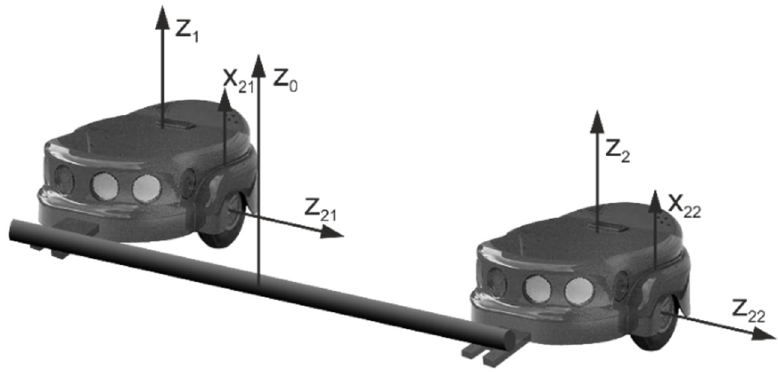
Figure 2. Distribution of external forces acting on the formation of robots.